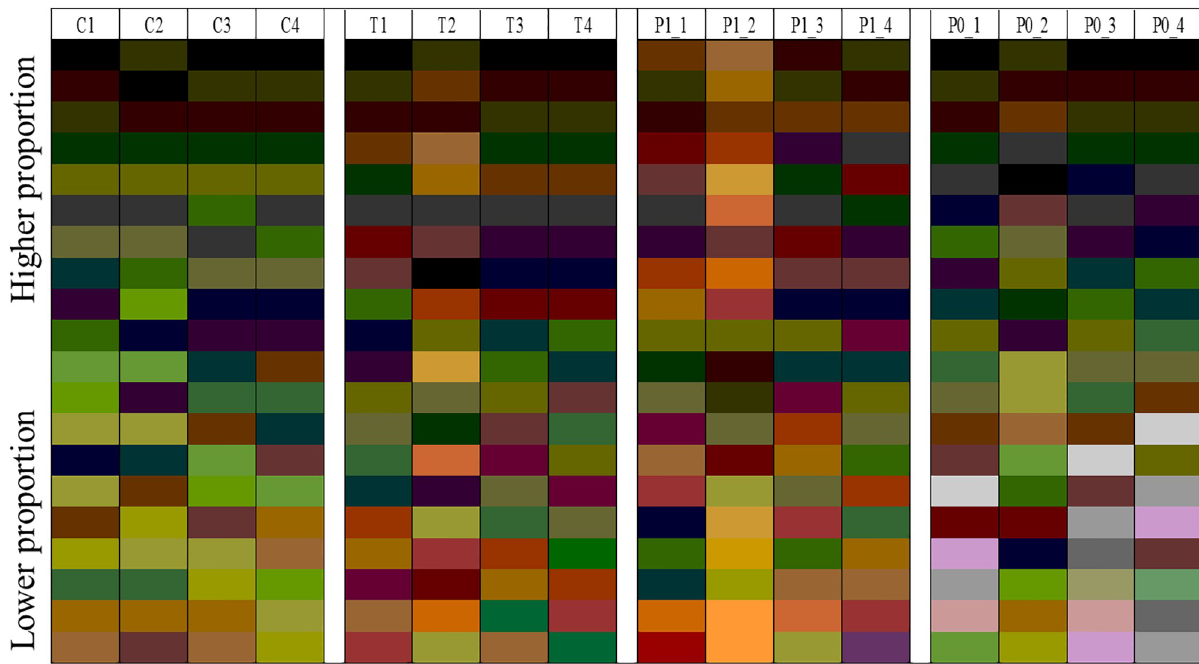
Fig 4. The top 20 colors resulted by image analysis in pictures of 5 DAT. C: Control; T: HP treatment (before segmentation); P1: Gray area directly affected by HP (after segmentation); P0: Nongray area not directly affected by HP (after segmentation).